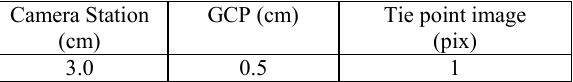
Table 3 – Standard deviations of the normally distributed errors added to the